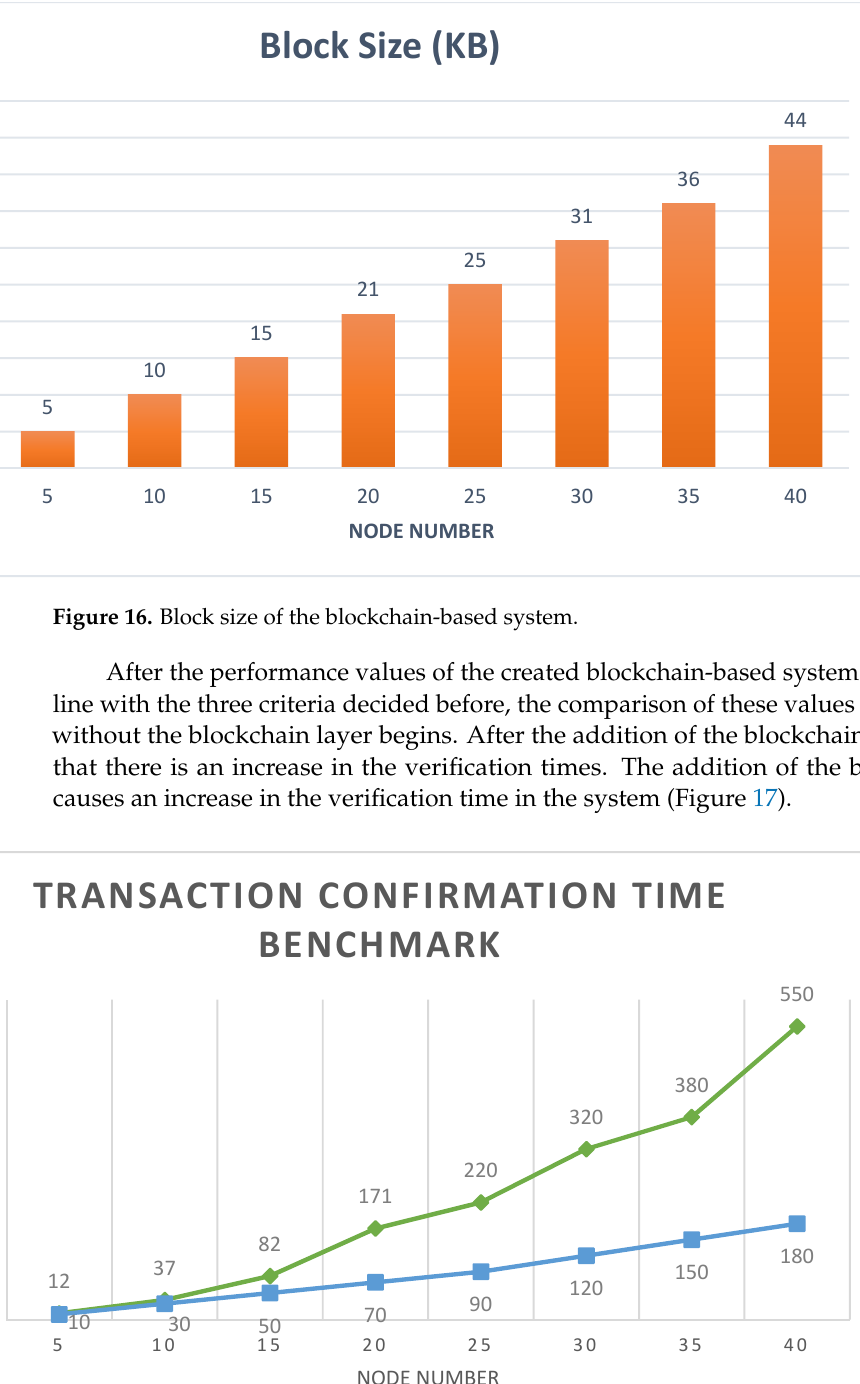
Figure 15. Throughput value of the blockchain-based system.